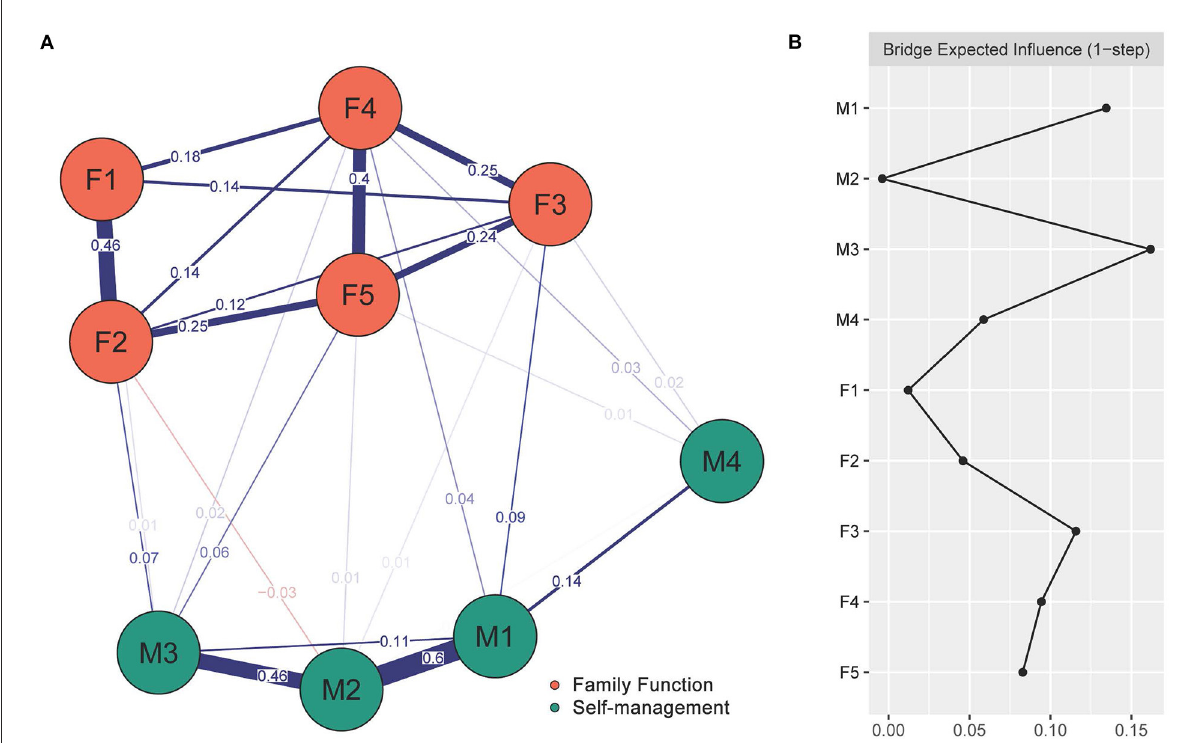
FIGURE1 The network model of family function and self-management and the bridge expected influence. (A) The network model of family function and self-management. The red edges indicate negative partial correlations, the blue edges indicate positive partial correlations, and thick lines and saturated colors indicate large partial correlation coefficients. (B) The bridge expected influence indices in the network of family function and self-management (raw score). F1, Adaptation; F2, Partnership; F3, Growth; F4, Affection; F5, Resolve; M1, Self-integration; M2, Problem-solving; M3, Seeking social support; M4, Adherence to recommended